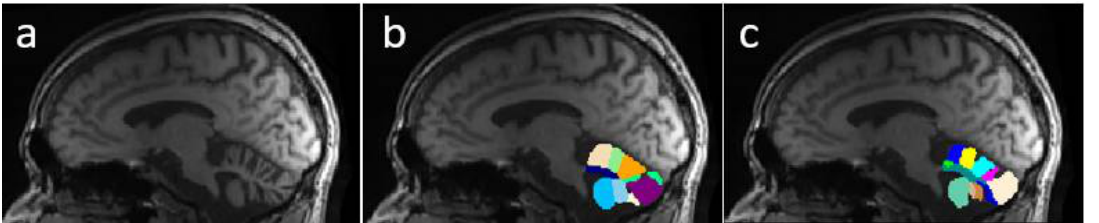
Figure 1. Comparison between segmentations on MRI of SCA2 patient. In ( a ) the original imaging, in ( b ) segmentation produced by ACAPULCO, and in ( c ) segmentation obtained by CERES.